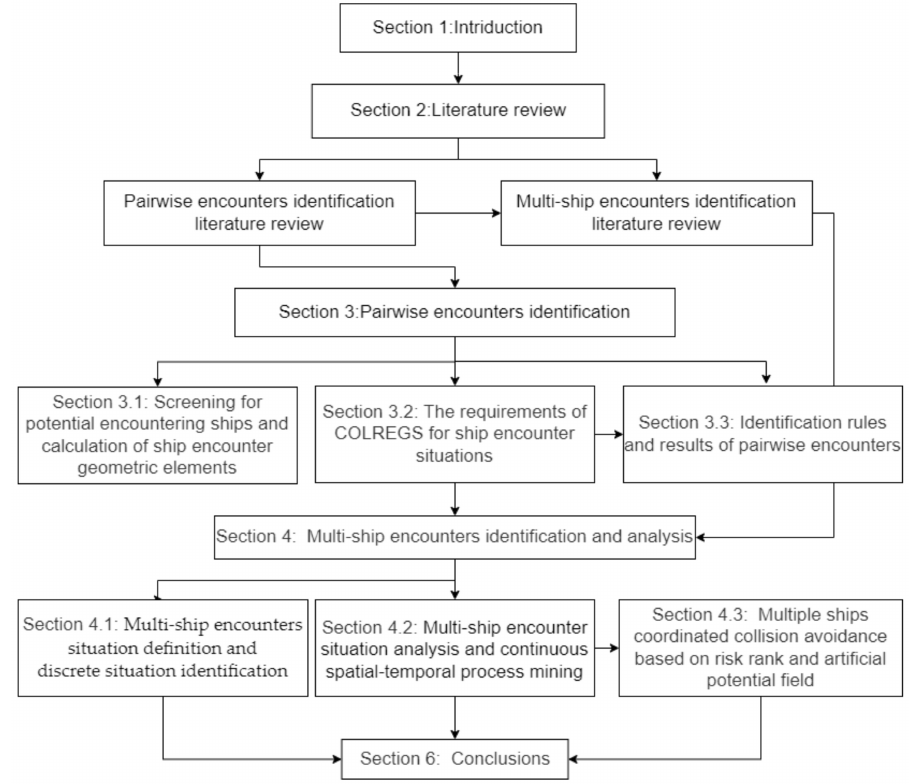
Figure 3. Section structure diagram of this